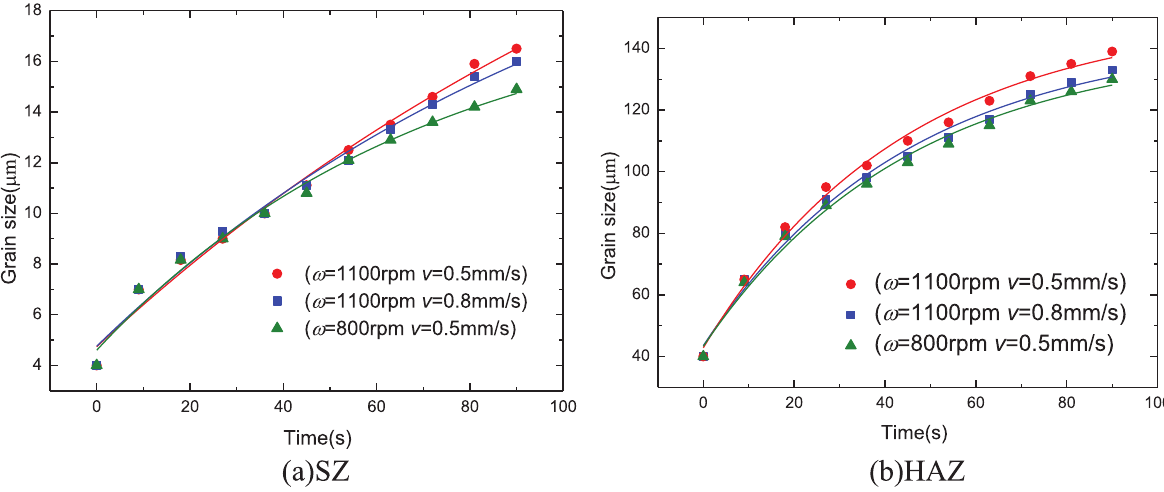
Figure 10: Variations of grain sizes with time in different welding